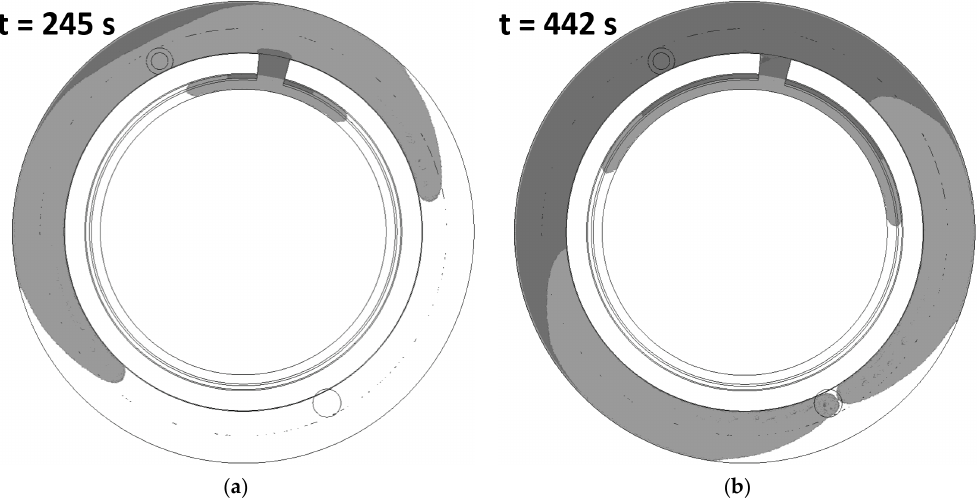
Figure 16. CFD result images of the fi lling process for “Top” case. ( a ) CFD result image at half time of the fi lling process; ( b ) CFD result image at touching time of the fi lling process.